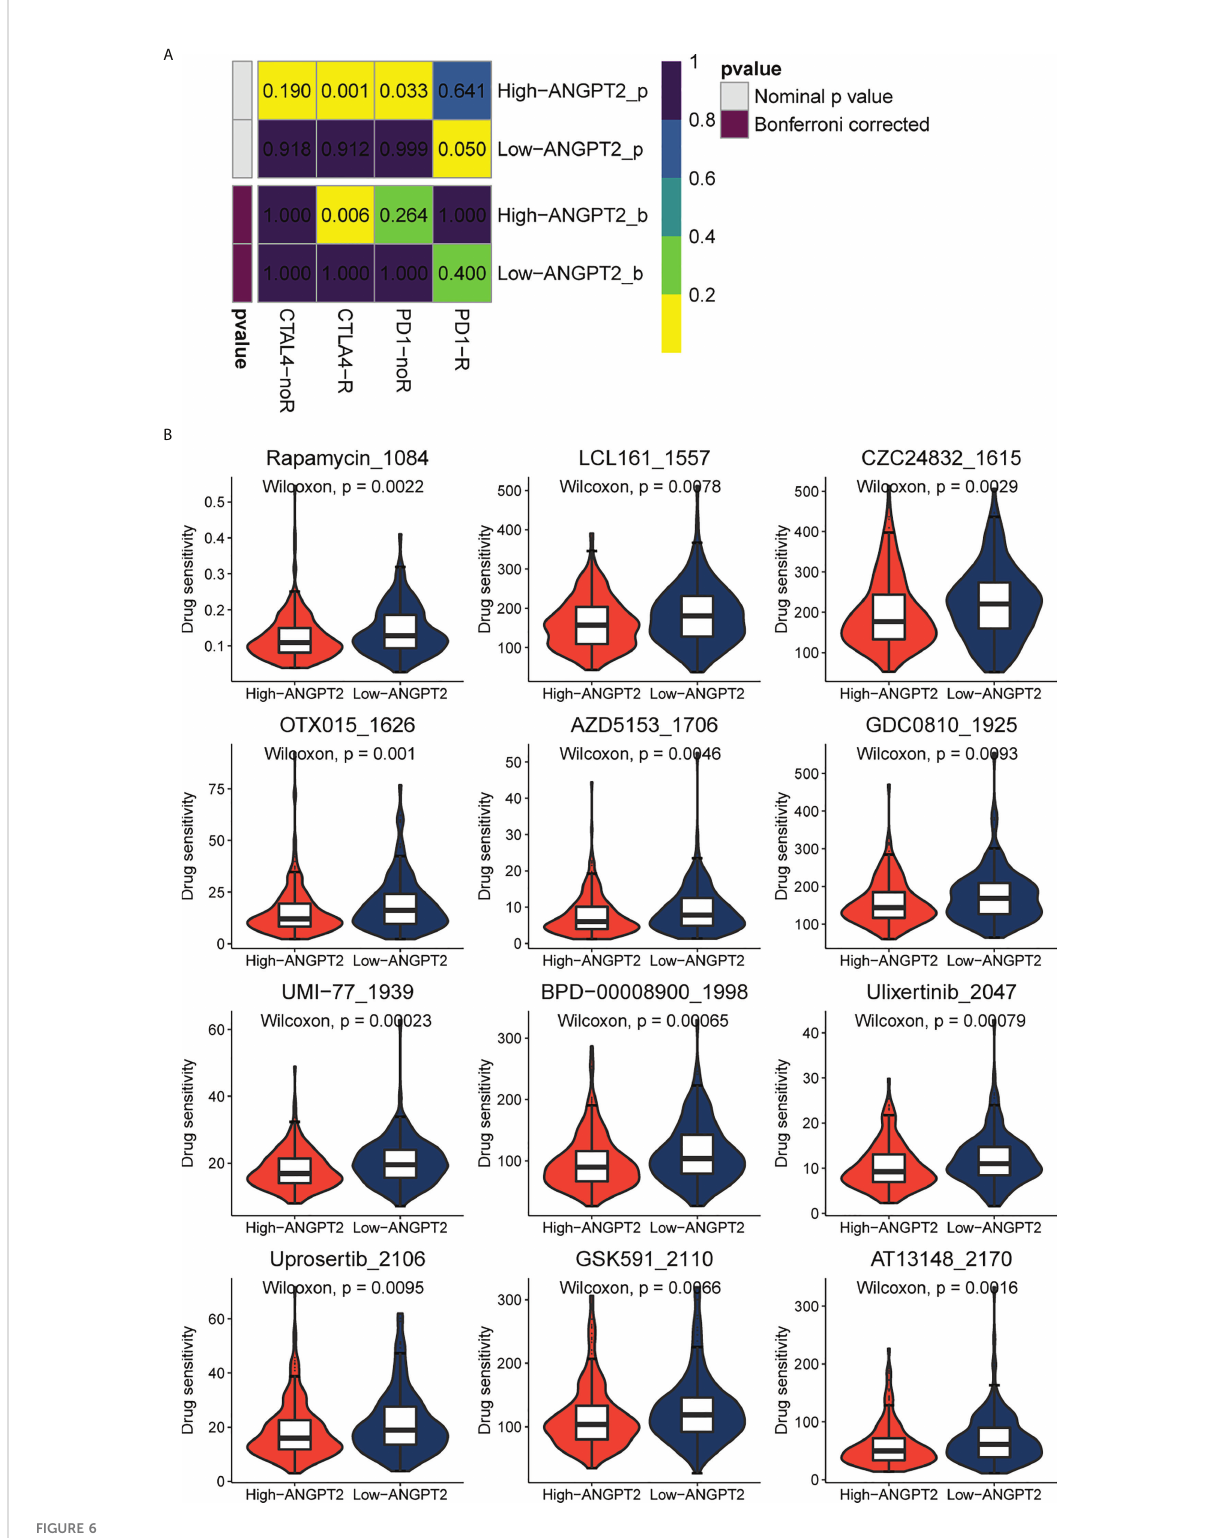
FIGURE 6 Immunotherapy and chemotherapy involved in ANGPT2 in TCGA-STAD. (A) Submap analysis of ANGPT2 levels in TCGA-STAD. (B) Box diagrams for estimating drug sensitivity of several GDSC chemotherapeutic drugs in the high ANGPT2 and low ANGPT2